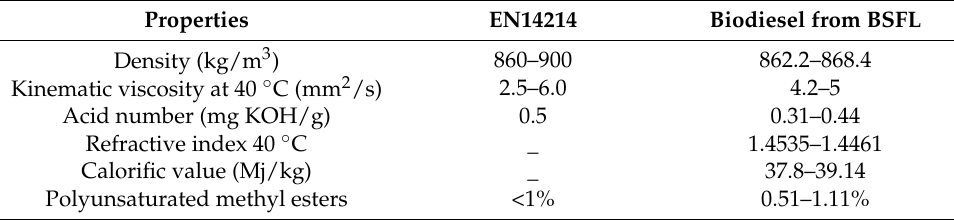
Table 5. Properties of BSFL biodiesel.